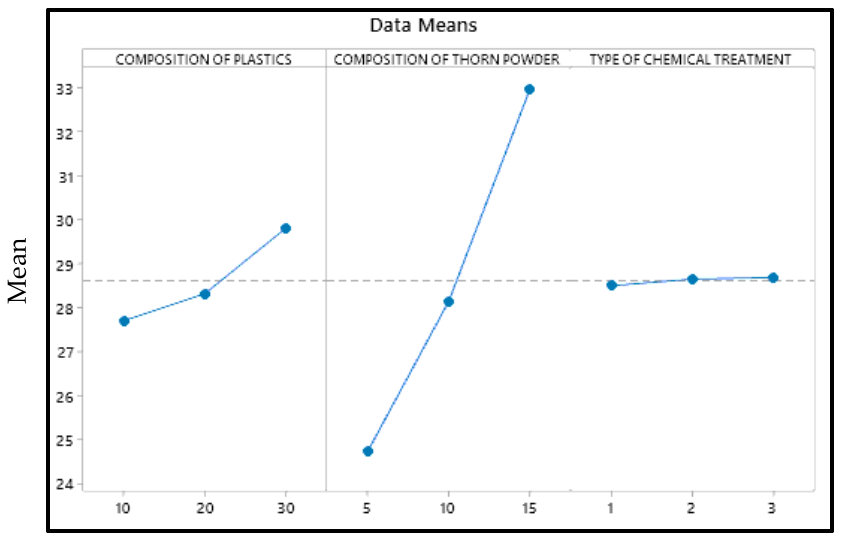
Figure 1. Effects chart for